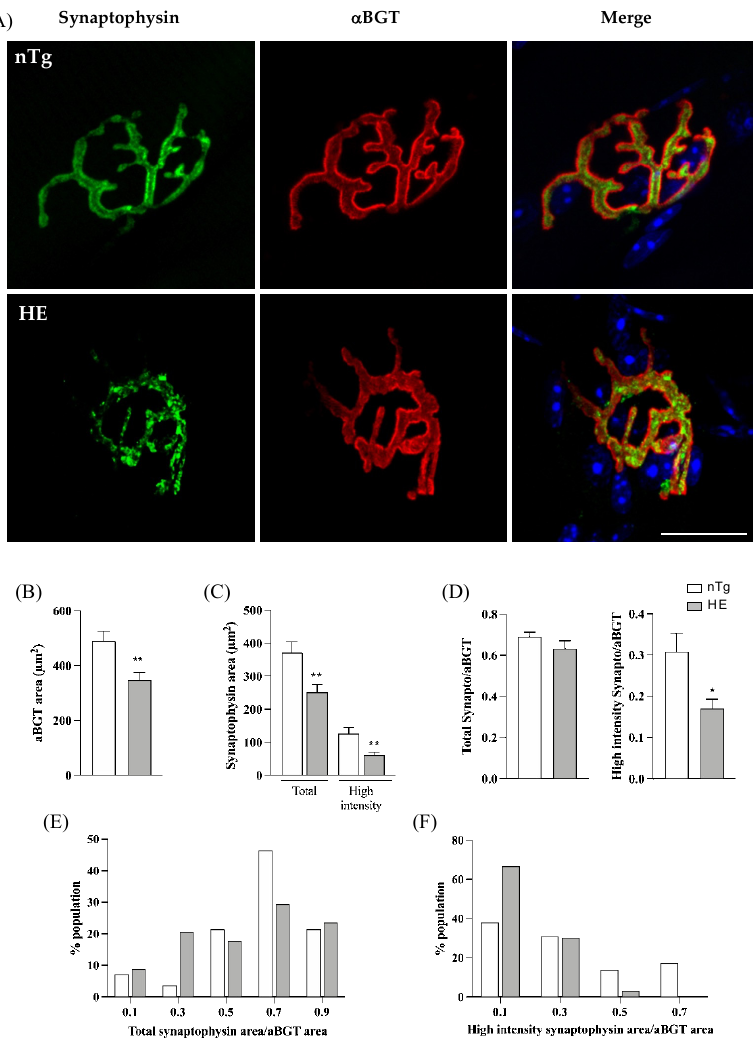
Figure 4. Synaptophysin distribution is altered in NMJ of 24-month-old HE mice. Representative confocal photographs showing typical EDL NMJ of HE and nTg mice ( A ). Rhodamine- α BGT-labelled nAChR delineate motor endplates (red), nerve terminals are labelled by immunodetection of synapto- physin (green) and nuclei (blue) are labelled with Hoechst 33342. Note the dot-like immunoreactivity of synaptophysin in HE mice compared to nTg mice. Scale bar: 20 µ m. ( B ) Measure of endplate area by quantification of the area of α BGT staining. No difference is seen between genotypes. ( C ) Measure of area covered by synaptophysin with two thresholds. A low threshold quantifying the whole surface occupied by the green staining corresponding to synaptophysin (Total) and a high threshold quantifying the high intensity of green staining. Note the decrease of synaptophysin area in both con- dition in HE compared to nTg mice. ( D ) Ratio of synaptophysin area to α BGT for the two thresholds used in ( C ) showing the relative overlap of synaptophysin on endplate; note the significant decrease in the ratio of the high intensity synaptophysin/ α BGT in HE compared to nTg mice. ( E ) Distribution of the total synaptophysin/ α BGT ratio in the NMJs population analyzed in ( D ). Note the increase in the percentage of NMJ with an overlap ranging from 0.2 to 0.4 and the decrease in the percentage of NMJ with an overlap ranging from 0.6 to 0.8 in HE compared to nTg mice. ( F ) Distribution of the high intensity synaptophysin/ α BGT ratio in the NMJs population analyzed in ( D ). Note the increase in the percentage of NMJ with an overlap ≤ 0.2 and the decrease in the percentage of NMJ with an overlap >0.4 in HE compared to nTg mice. ( B – D ) Histograms represent means ± SEM; n = 8–10/mice per genotype and 6–10 JMN/mice. * p < 0.05, ** p < 0.01, Student’s t -test ( B ) or Mann–Whitney test ( C , D